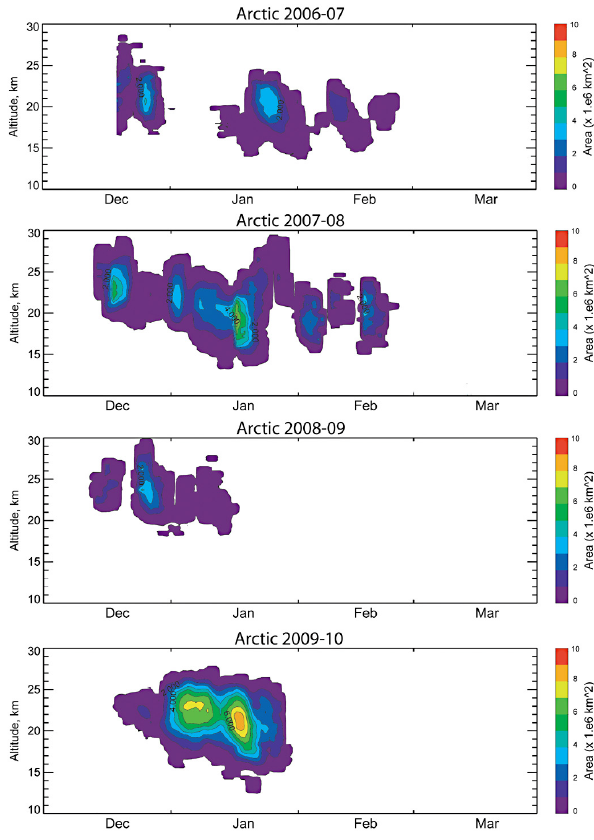
Fig. 9. Daily areal coverage of PSCs as a function of altitude for the four Arctic winters in the CALIPSO data record to